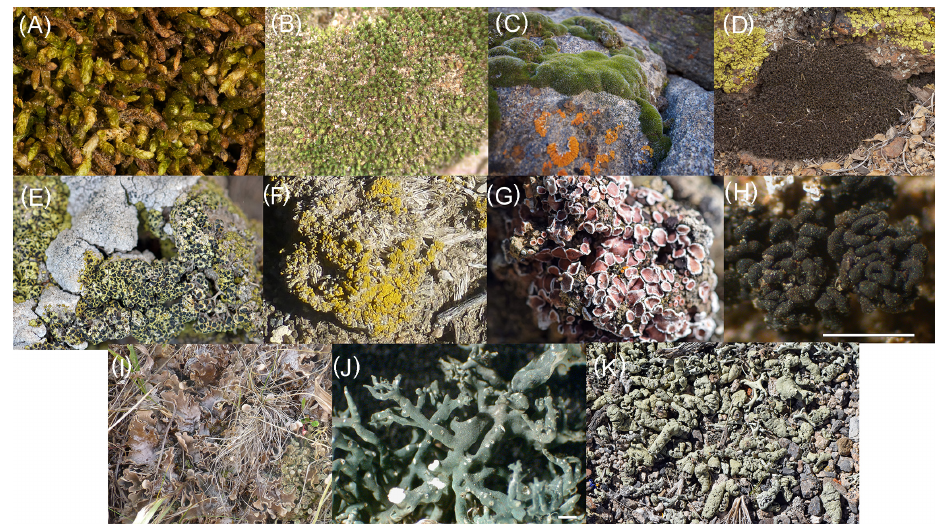
Figure A1. Photographs of functional groups; note that scale varies and most do not include scale bars. (a) Mat bryophyte Eurhynchiastrum (Photo: JB), (b) short turf bryophyte Gemmabryum (Photo: JB), (c) cushion bryophyte Grimmia (Photo: JB), (d) tall turf bryophyte Syntrichia (Photo: JB), (e) thick lichen crusts Acarospora schleicheri (yellow) and Diploschistes muscorum (white) (Photo: EKD), (f) thin lichen crust Candelariella (Photo HTR), (g) squamulose lichen Psora decipiens (Photo: EKD), (h) small foliose lichen Enchylium tenax (Photo: Bruce McCune, scale bar = 1cm), (i) large foliose lichen Peltigera (Photo: HTR), (j) fruticose lichen Circinaria hispida (Photo: Bruce McCune, scale bar = 1mm), and (k) vagrant lichens Rhizoplaca (rolled up) and Xanthoparmelia (Photo: EKD).